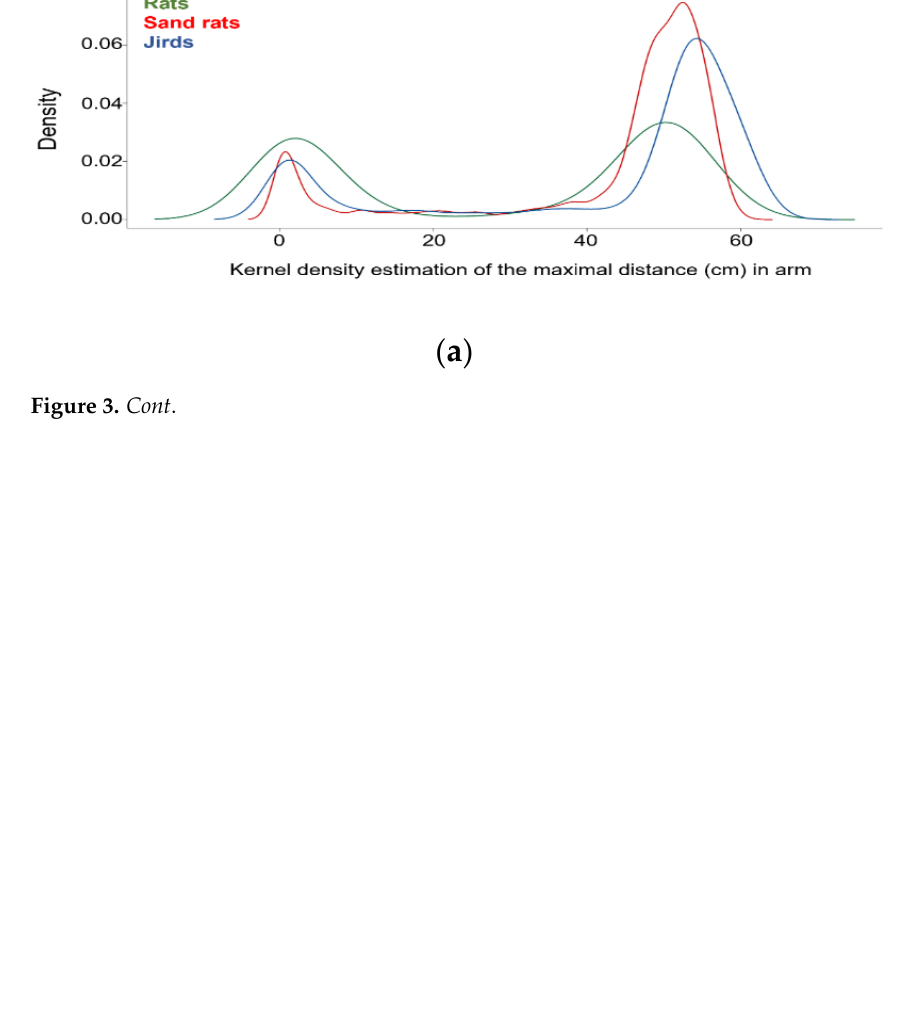
Figure 2. Distance traveled in the upper vs. the lower arm. In each inclination in each of the three species, the distance travelled by each rodent in the upper arm (ordinate) is plotted against the dis- tance traveled by the same rodent in the lower arm (abscissa). Accordingly, for each species, each dot represents one rodent in one inclination. The various inclinations of the upper and lower arms are depicted at the top of the figure. The diagonal dashed line is the equivalence line along which the distance traveled in both arms was identical. As shown, rats aggregated near the line of equiva- lence, although those tested in 0° were blow the line (traveled a little more in the lower arm), those tested in 15° were on the line of equivalence, those tested in 30° were above the line (traveled a little more in the upper arm), while those tested in 45° and 60° ceased to travel in both arms. While the diminished travel in the higher latter inclinations is also apparent in jirds and sand rats, in the shal- lower inclination almost all sand rats and jirds aggregated below the line of equivalence (traveled greater distances in the lower arm). 3.6. Rodents Traveled Either All the Way or about Half-Way along the Inclined Arms When traveling along the upper or lower arms, the rodents tended to turn back either at the far end of the arm or up to half-way to the end. Indeed, Kernel Density Estimation (KDE) of the maximal point reached at both the upper and lower arms revealed a bimodal